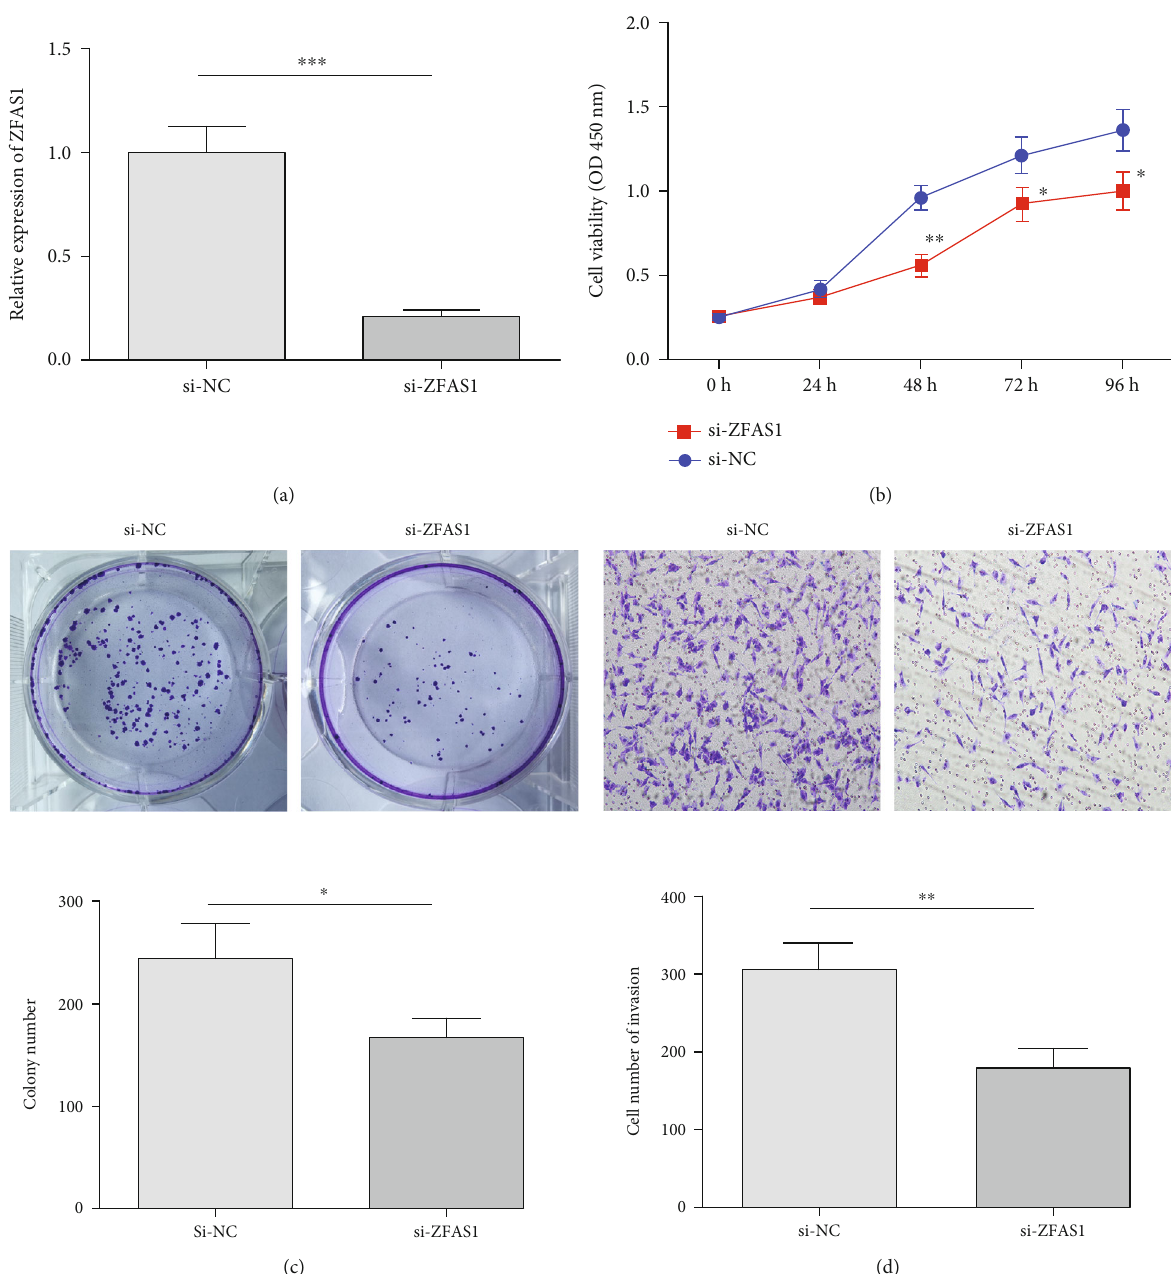
Figure 2: Impact of ZFAS1 knockout on biological function of PC cells. (a) ZFAS1 expression; (b) cell viability; (c) plate clonal cell formation; (d) cell invasiveness; ∗ P < 0 : 05 ; ∗∗ P < 0 : 01 ; ∗∗∗ P < 0 : 001